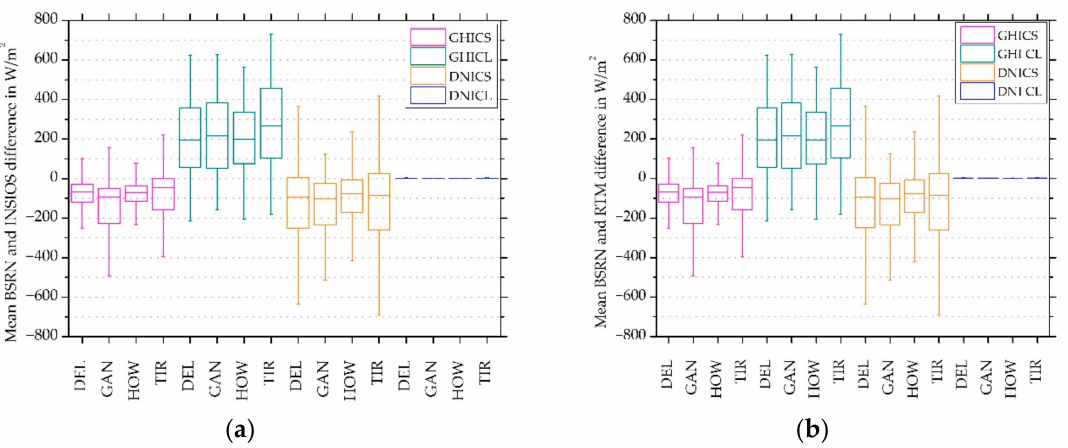
Figure8. Half-hourlymeanGHIandDNIdi ff erencesderivedfrom( a )INSIOSand( b )RTM,ascompared to BSRN data for clear and cloudy